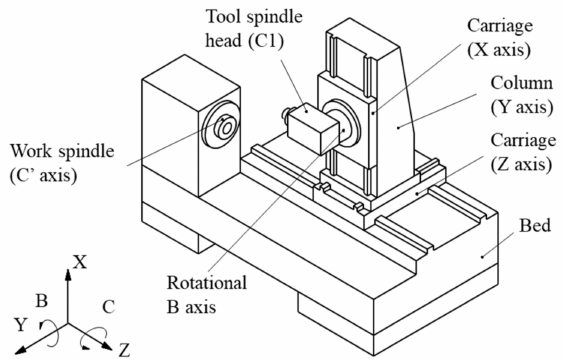
Figure 1. Schematic view of a multi-tasking machine tool with a swivel tool spindle head in horizontal position.